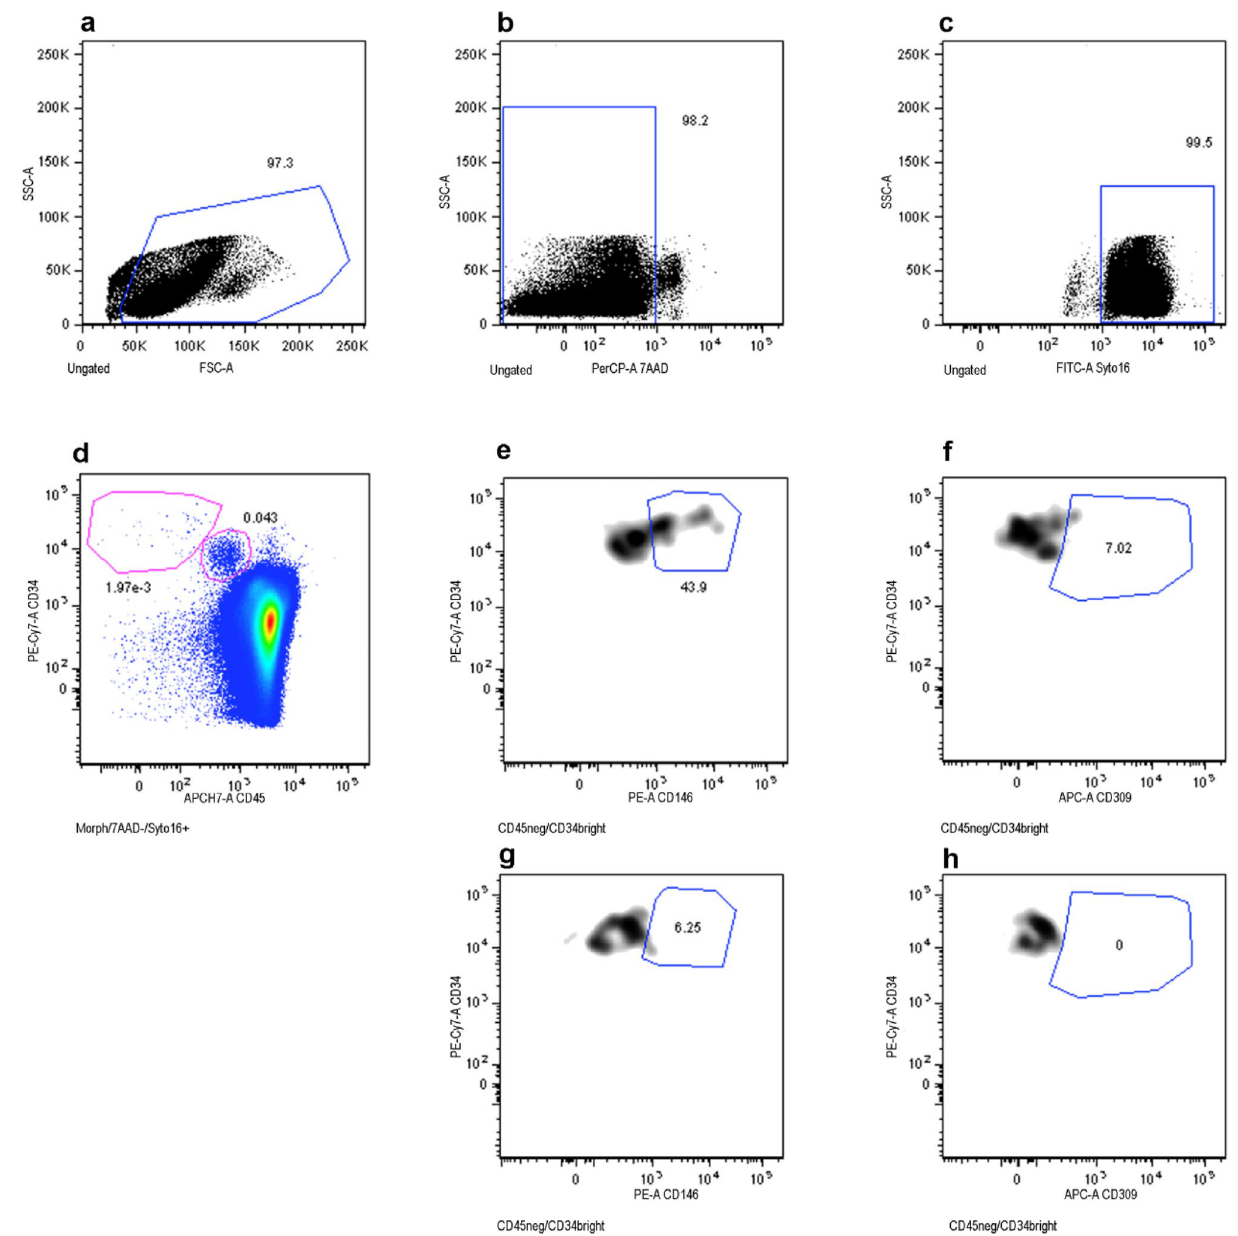
Figure 5. Events displaying the typical lympho-monocyte morphology were first selected in a forward scatter (FSC) versus side scatter (SSC) dot-plot ( a ). Dead cells were excluded on the basis of their positivity to 7-AAD ( b ) and nucleated events (Syto16 + , c ) were gated. Regions identified in ( a – c ) were logically intersected and cells resulting from this combination (lympho-monocyte morphological features, alive and nucleated), were then analysed for their phenotypes. Two subpopulations were identified on a CD45/CD34 dot-plot: CD34 positive cells (hematopoietic stem cells) and a CD34 bright cells ( d ). The CD45 neg /CD34 bright cell population was then analysed for CD146 and CD309 expression, on CD146/CD34 and CD309/CD34 dot plots, respectively ( e , f ), and compared with the respective control tube dot-plots, containing the isotype control of the anti-CD146 and anti-CD309 in combination with all the remaining reagents ( g , h